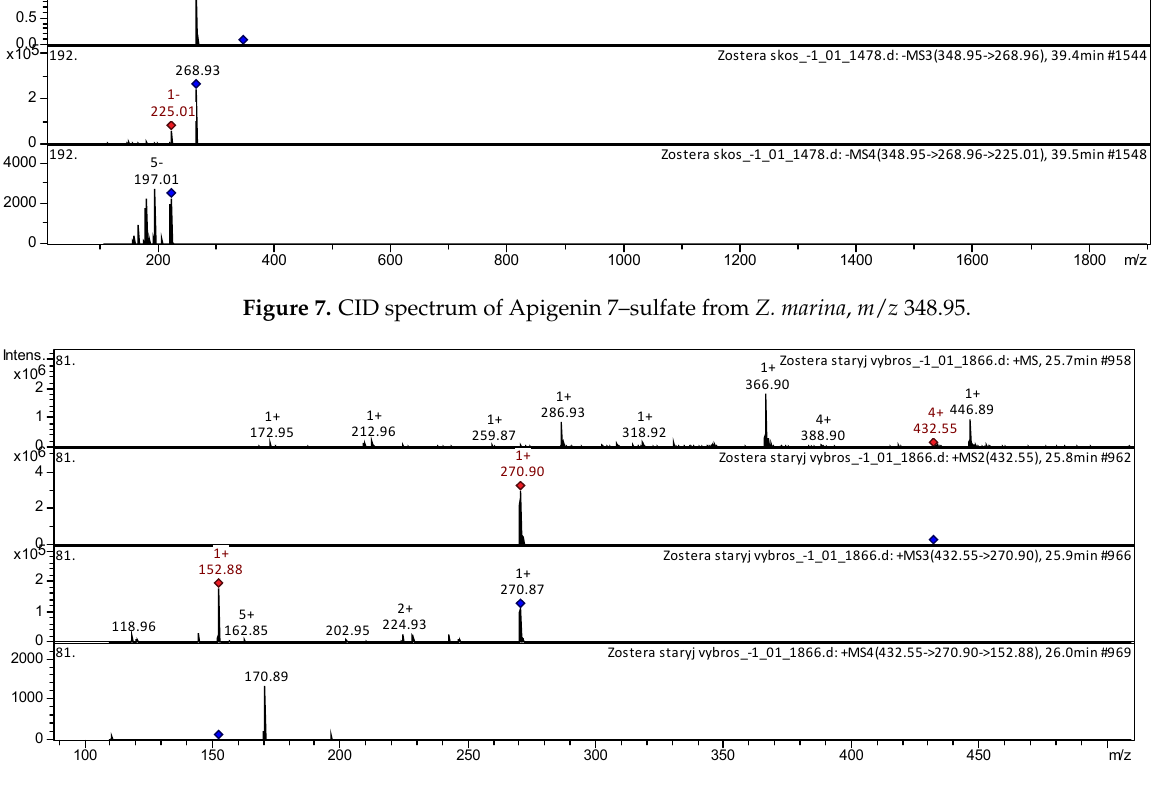
Figure 7. CID spectrum of Apigenin 7–sulfate from Z. marina , m/z 348.95.